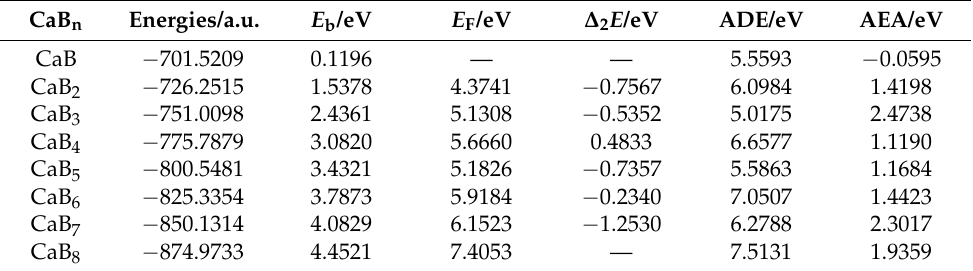
Table 1. The energies, the average binding energy ( E b ), the fragmentation energy ( E F ), second-order difference of total energy ( ∆ 2 E ), adiabatic detachment energy (ADE), and adiabatic electron affinity (AEA) of the CaB n clusters of the most stable structures of CaB n at the MP2/6-311+G(d)//B3LYP/6-311+G(d) level. CaB n Energies/a.u. E b /eV E F /eV ∆ 2 E /eV